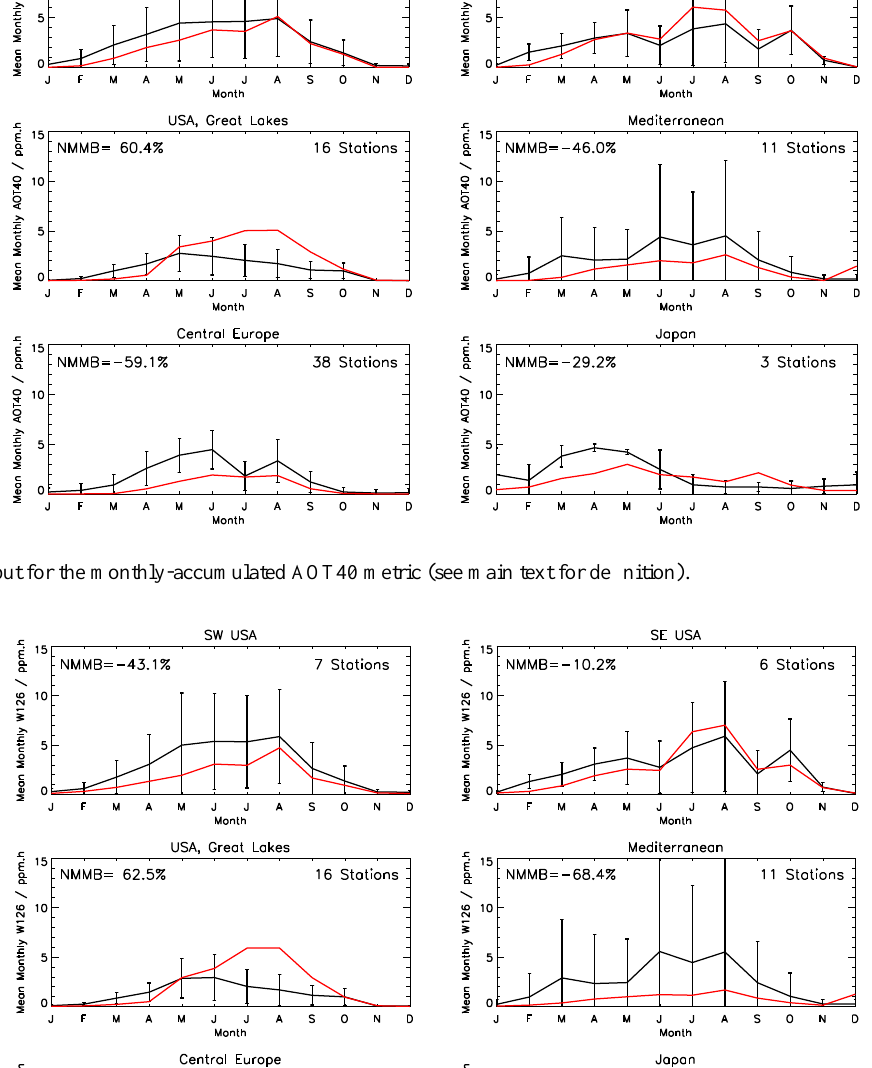
in agreement between the model and observed M12 com- pared to the comparison of monthly-mean ozone concentra- tion. This indicates that the model over-predicts nighttime ozone. This may be linked to the surface model ozone hav- ing a potential positive bias in regions where model vertical